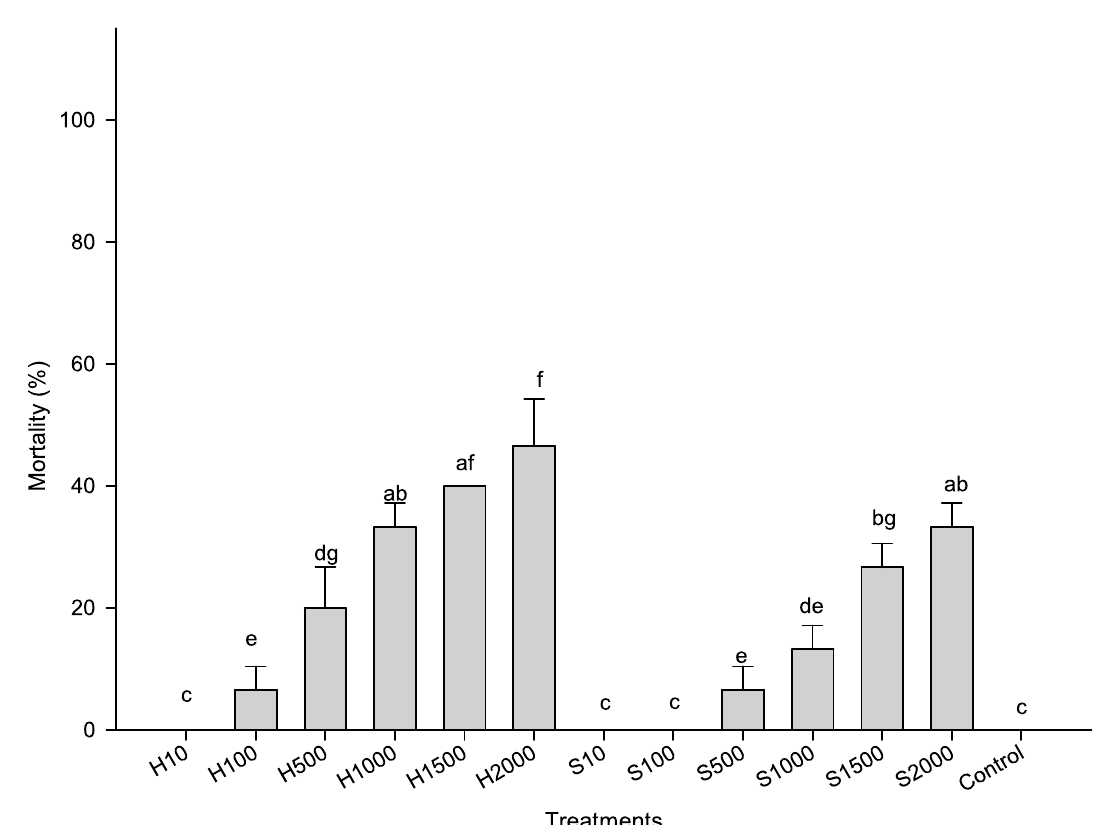
Fig. 2 Pathogenicity of entomopathogenic nematodes on adults of Cosmopolites sordidus . Means with the same letter were non-significantly different ( P < 0.05, Conover’s